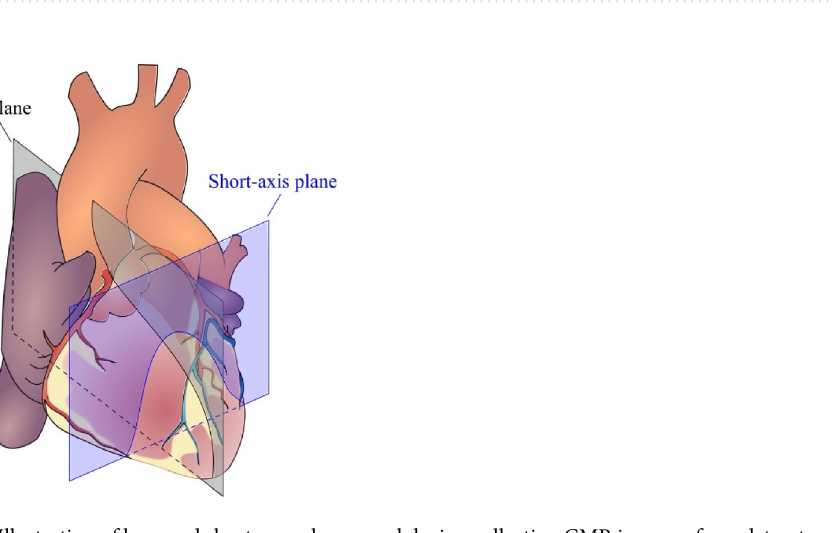
Figure 3. Example cardiac magnetic resonance images from coronary artery disease patients ( a – c ) and healthy subjects ( d – f ). c is a black-blood spinecho image; the rest are single-phase images of steady-state free precession CINE images. The lesions indicating CAD have been marked with yellow color in parts ( a–c ).